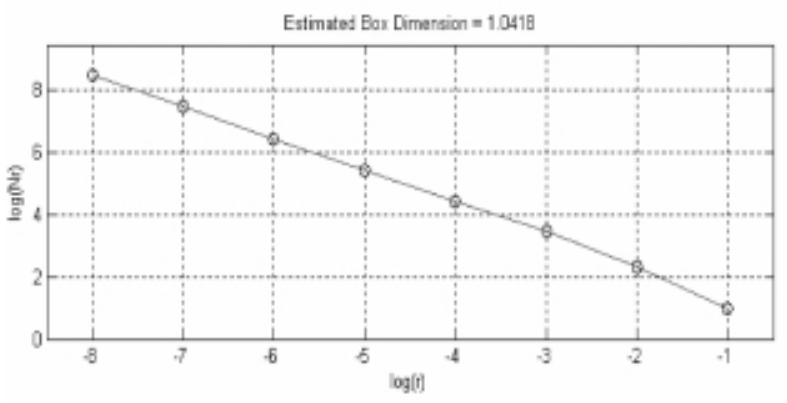
Fig. 3. Straight line box counting dimension estimation result.